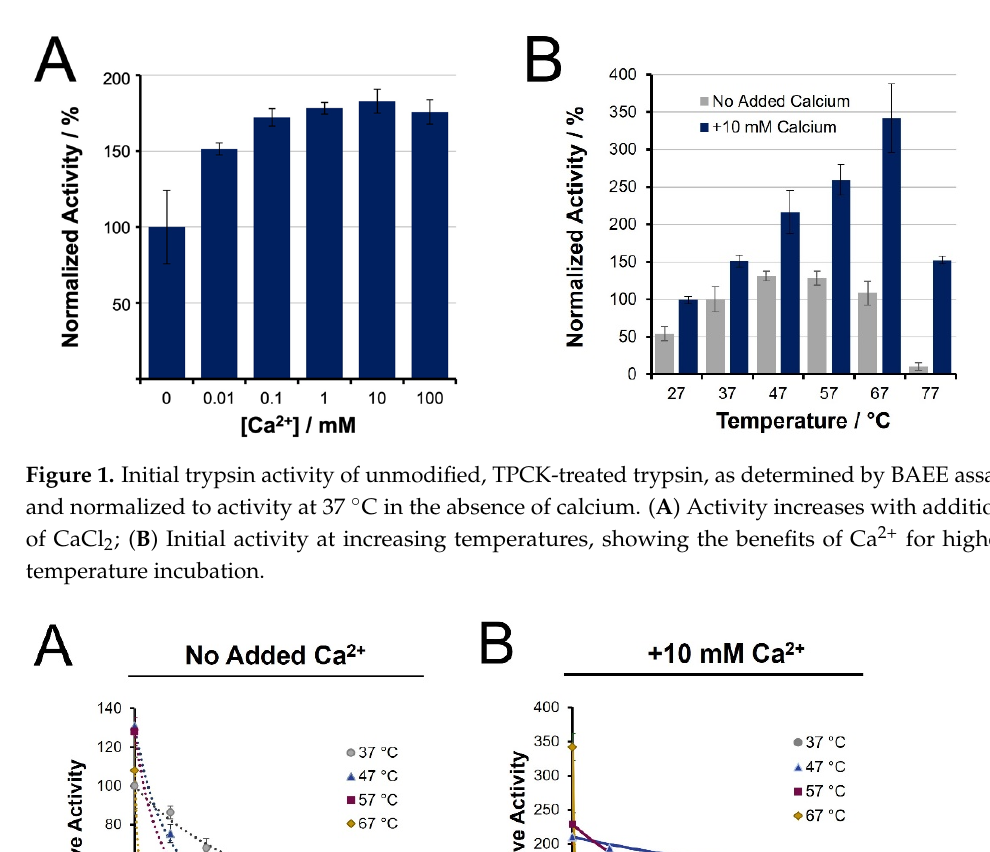
Figure 1. Initial trypsin activity of unmodified, TPCK ‐ treated trypsin, as determined by BAEE assay, and normalized to activity at 37 °C in the absence of calcium. ( A ) Activity increases with addition of CaCl 2 ; ( B ) Initial activity at increasing temperatures, showing the benefits of Ca 2+ for higher tem ‐ perature incubation.